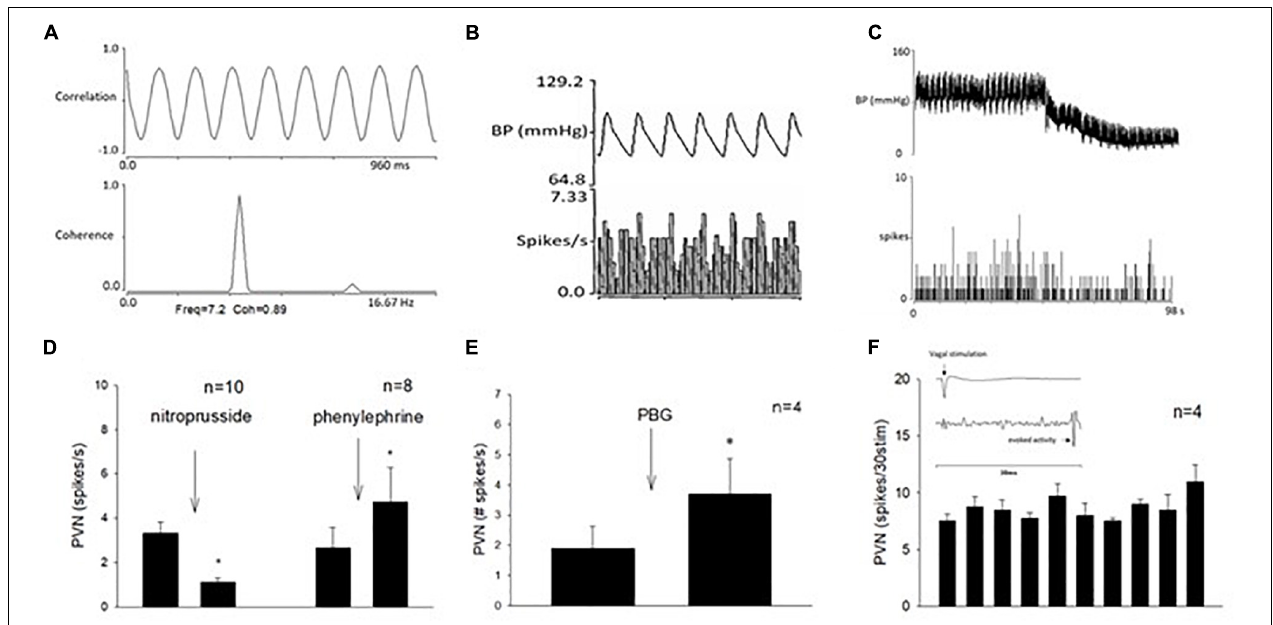
FIGURE 6 | Methods used to classify paraventricular nucleus (PVN) neurons that received input from the vagal nerve, the median nerve, and the baroreceptor. (A) Displays strong correlation and coherence between PVN neuronal activity and blood pressure. (B) Shows time domain analysis of a strong relationship between PVN discharge and blood pressure. (C) Displays recording of blood pressure (BP) and activity of PVN neuron (receiving vagal input) after intravenous nitroprusside. Group data of PVN neuronal activity following administration of nitroprusside and phenylephrine (D) . (E) Shows with a bar histogram the evoked activity in the PVN following PBG intravenous administration. (F) Displays consistent evoked PVN activity by repeated cervical vagal nerve stimulation. The inlay displays time of vagal stimulation and its evoked spike in PVN (F) . *Indicates significant difference in PVN activity following administration of nitroprusside or phenylephrine (D) or PBG (E)